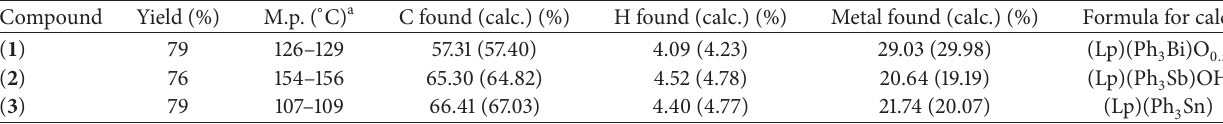
Table 1: Yields and elemental analyses of the